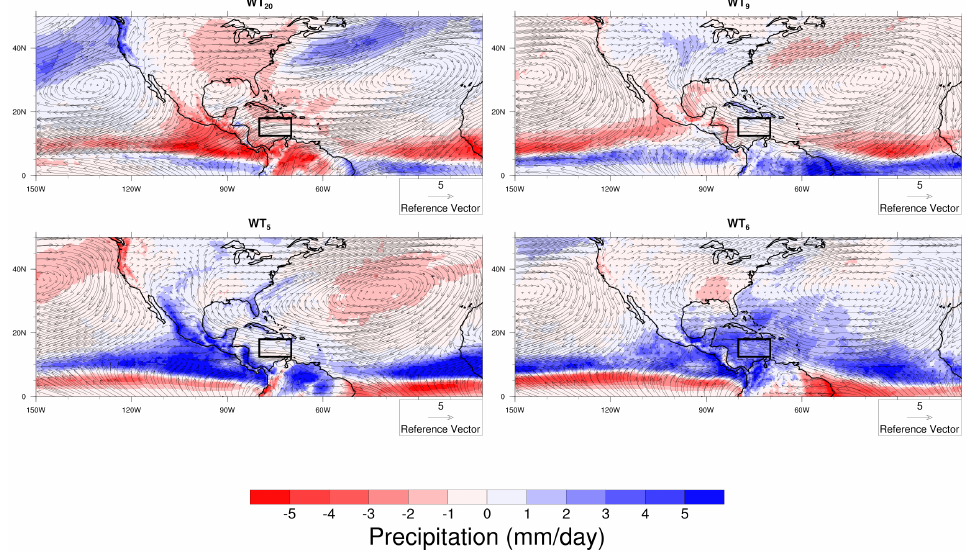
Figure 6. Composite averages of wind at 925 mb (arrows in m s − 1 ) and CHIRP anomaly (colors) fields per SOM node. Box-limited area (lower left corner at 12.5 ◦ N and 80 ◦ W; upper right corner 18 ◦ N and 70 ◦ W) corresponds to the Caribbean Low-Level Jet (CLLJ) core as defined by Wang